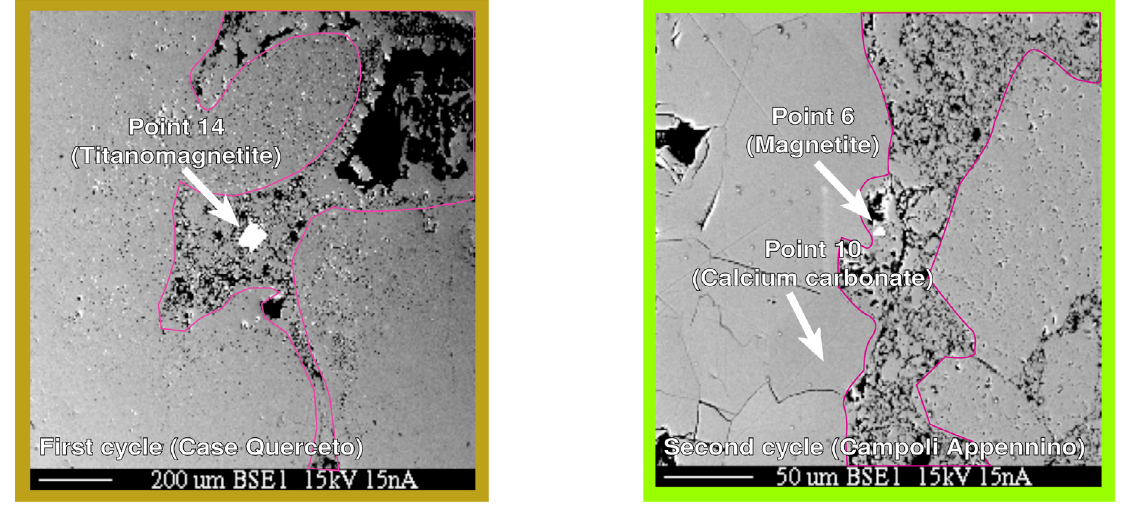
Figure 3. Electron micrographs of thin sections. Mineral identifications are given for selected points; see Table 1 for detailed composition